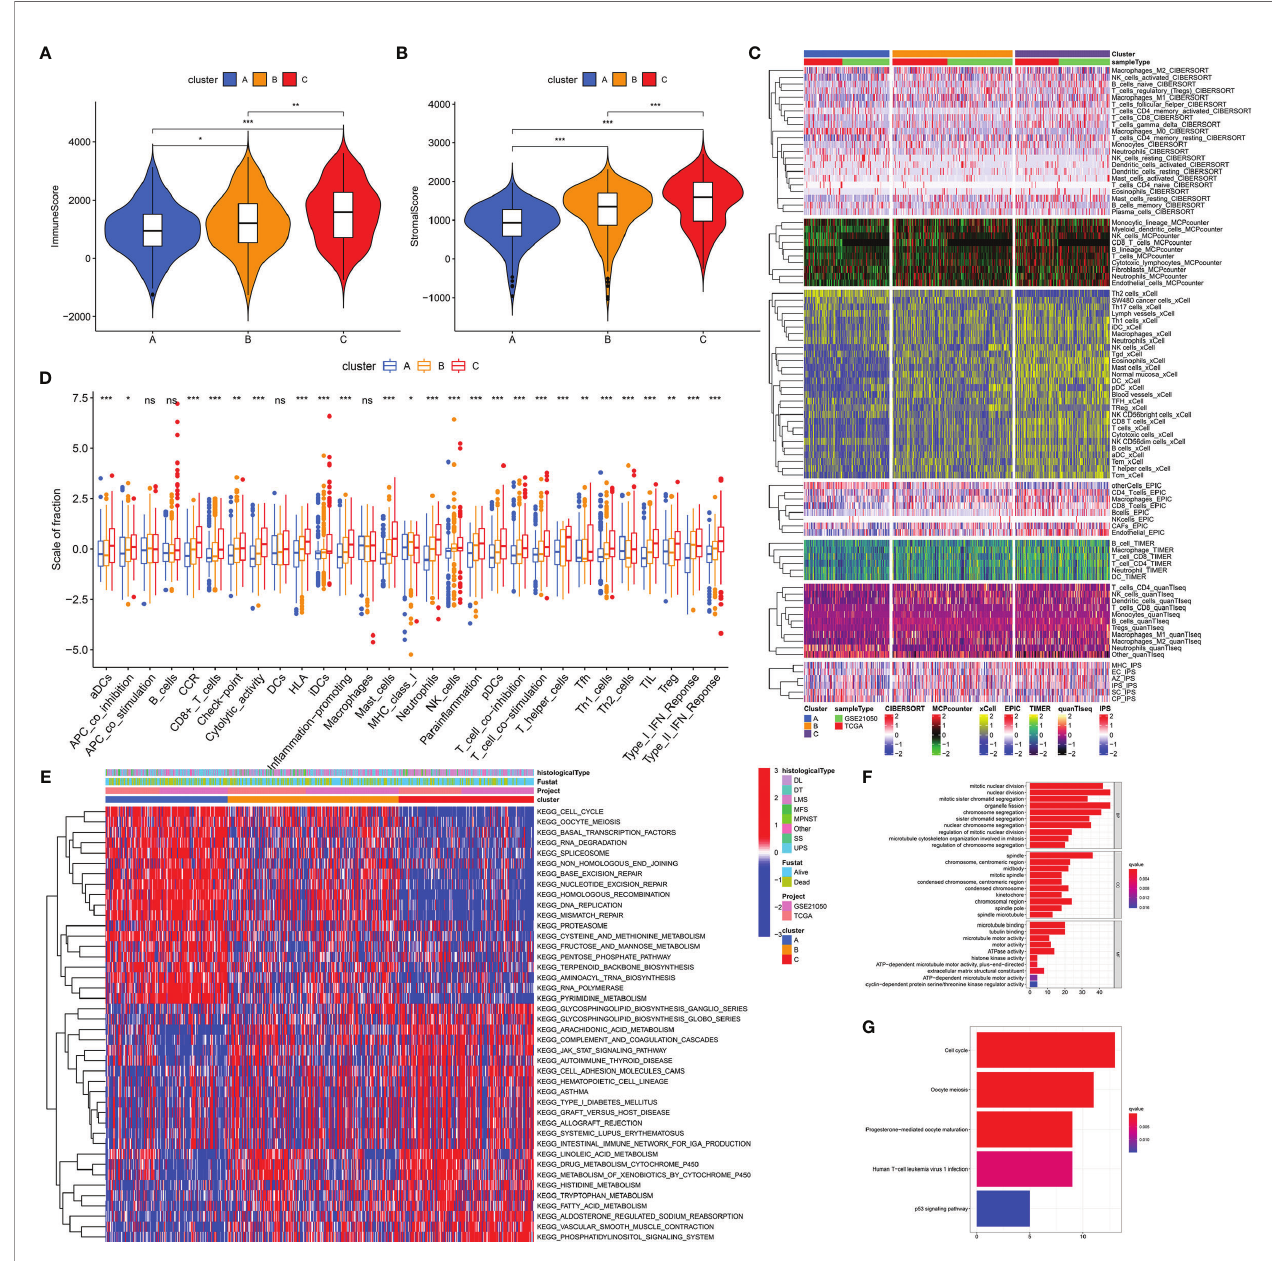
FIGURE 3 | Distinct biological differences in stemness subtypes. The differences of immune (A) and stromal (B) scores among three subtypes (clusters A, B, and C) in the overall cohort. (C) The heatmap of immune in fi ltration (calculated by seven methods) among three subtypes. (D) The differences of enrichment scores of 29 immune gene sets re fl ective of innate and adaptive immunity among three subtypes. (E) The heatmap of differences of GSVA scores of KEGG pathways. GO (F) and KEGG (G) analyses of DEGs from three stemness subtypes. ***p < 0.001; **0.001 < p < 0.01; *0.01 < p < 0.05; ns (not signi fi cant), p >